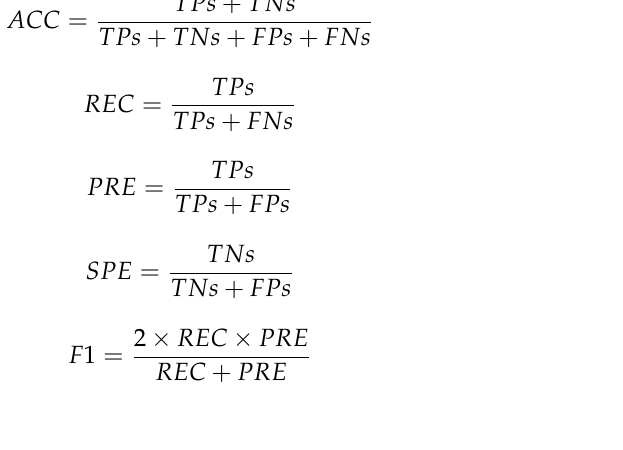
Table 3. Confusion